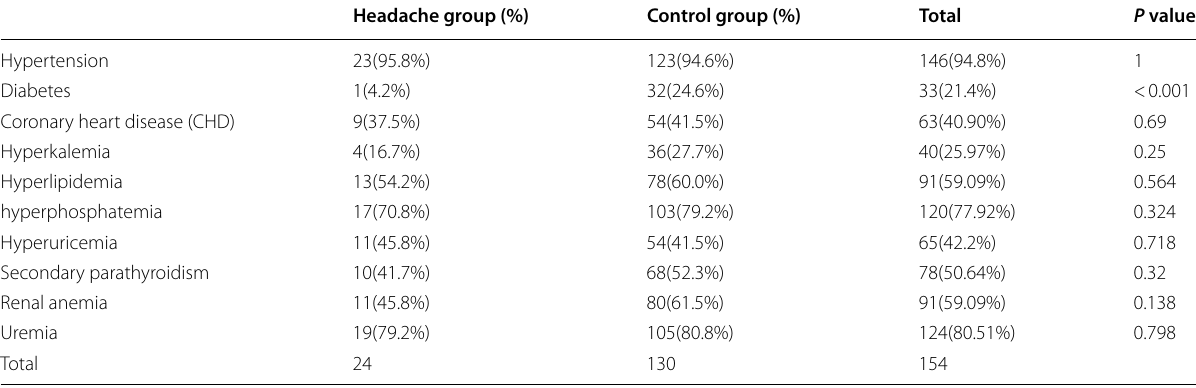
Table 2 Comorbidities of hemodialysis